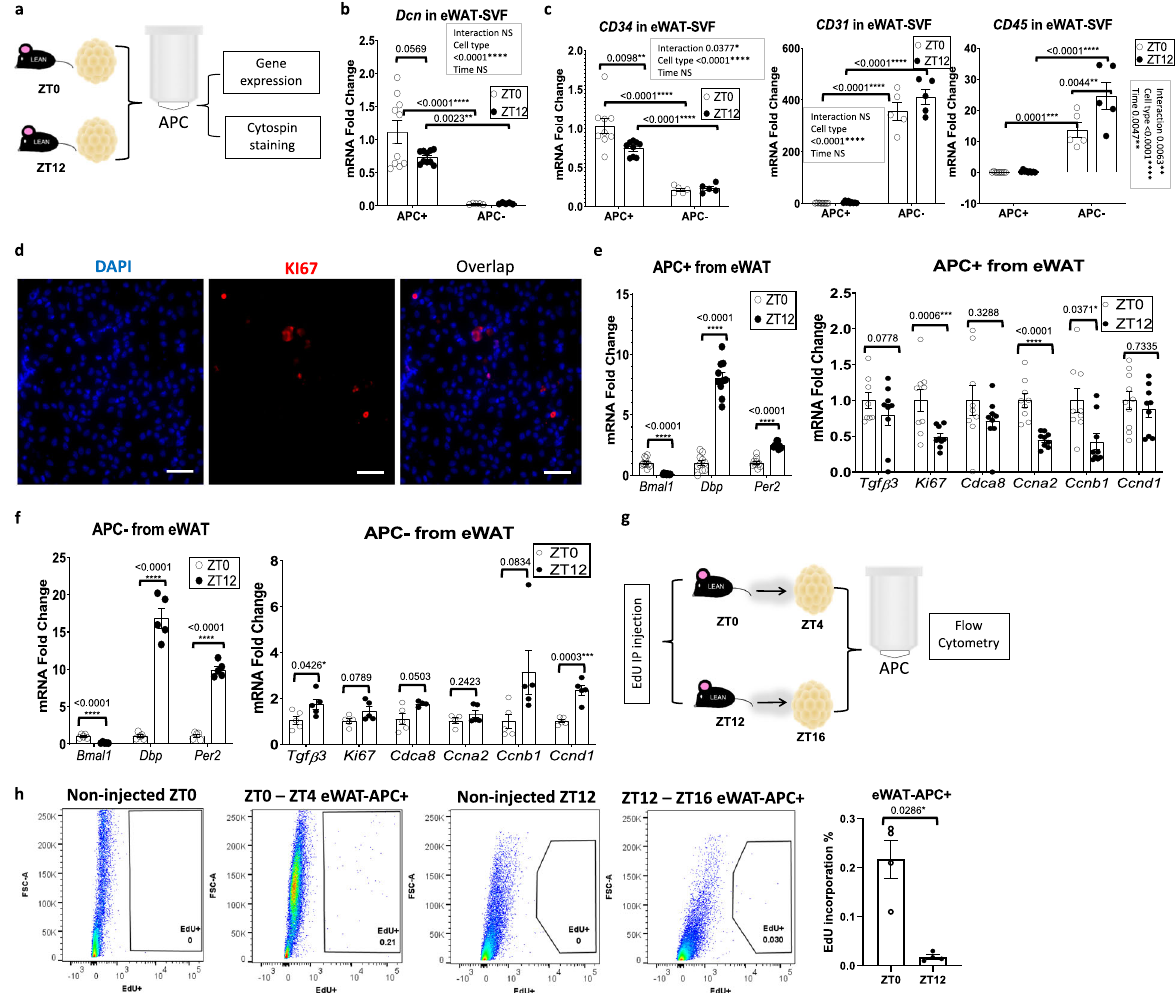
Fig. 2 Diurnal proliferation of adipocyte progenitor cells (APCs) in epididymal adipose tissue (eWAT). a Experimental model: adipose progenitor cells (APC) within the eWAT and iWAT stromal vascular cells were isolated at ZT0 and ZT12 from lean mice fed ad libitum control chow, for further gene expression and immunostaining analysis. b , c RT-PCR analysis reveals expression of progenitor (Dcn and CD34), endothelial (CD31), and lymphocyte (CD45) markers in eWAT/APC and eWAT/non-APC cells from lean mice isolated at ZT0 and ZT12 ( n = 5 animals for APC − and n = 10 animals for APC + /zeitgeber time, ZT). mRNA levels for lean mice at APC + /ZT0 were set to 1 for all genes. d Representative staining of KI67 (vs. DAPI) in eWAT-APC (scale bar = 50 µ m). Staining performed once from 3 biological replicates. e , f RT-PCR analysis reveals expression of circadian (left panel) and proliferation genes (right panel) in eWAT/APC ( e ) and eWAT / non-APC cells ( f ) from lean mice isolated at ZT0 and ZT12 ( n = 5 animals for APC − and n = 10 animals for APC + /ZT). mRNA levels for lean mice at APC + /ZT0 were set to 1 for all genes. g Experimental model: EdU was administered to lean mice fed ad libitum control chow at ZT0 and ZT12. eWAT and iWAT SVF were isolated from fat pads harvested 4 h following EdU injection and the subsequent adipose APC were isolated for further analysis. h Representative fl uorescence activated cell sorting of EdU-positive cells in eWAT-APC isolated at ZT4 and ZT16, 4 h following a single EdU injection (left panel). Right panel: Quanti fi cation for total EdU + APC ( n = 5 animals/ZT). For all bar graphs, white and black circles represent ZT0 and ZT12, respectively. Data are represented as mean ± SEM. * p < 0.05, ** p < 0.01, *** p < 0.001, **** p < 0.0001. Signi fi cance ( p < 0.05) determined by two-way ANOVA and Tukey ’ s post-hoc test in b-c; two-tailed unpaired T-test in e-f; and two-tailed Mann – Whitney U test in